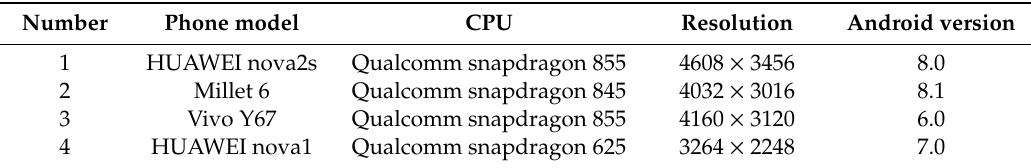
Table 1. Specifications of Android